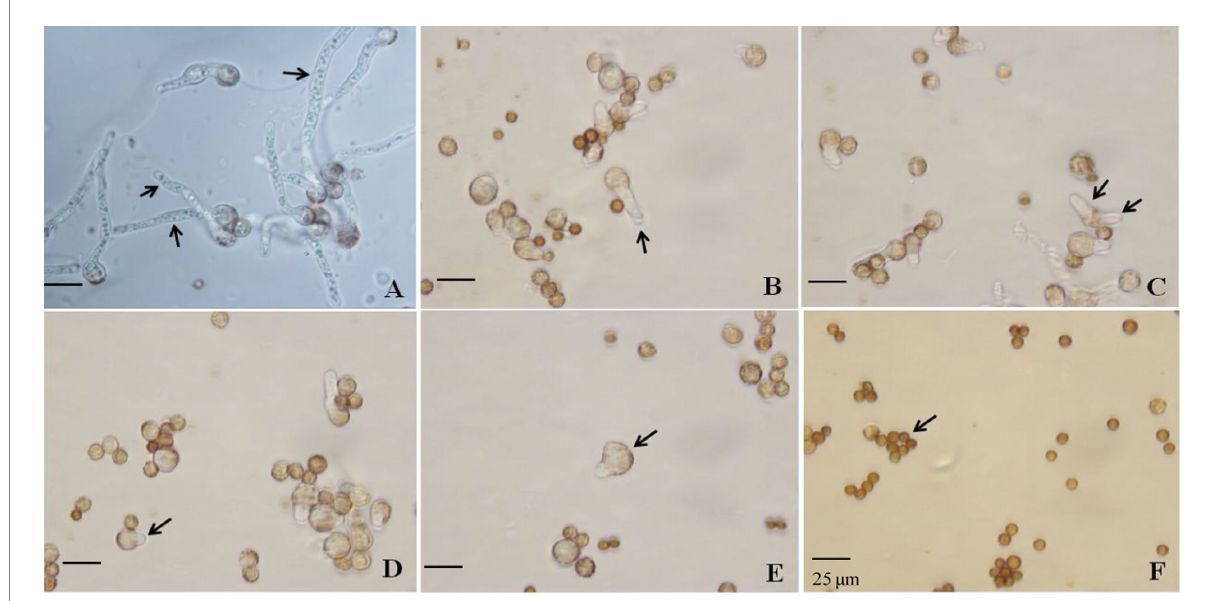
FIGURE 2 Effect of SBC, NT, and the combination treatment on spore germination of Aspergillus niger . (A) Control; (B) 6.0 g/L SBC; (C) 2.5 mg/L NT; (D) 5.0 mg/L NT; (E) 4.0 g/L SBC + 2.5 mg/L NT; (F) 4.0 g/L SBC + 5.0 mg/L NT, 24 h after inoculation. Images were obtained by microscopy at 1,000× magnification, bar = 25 μ